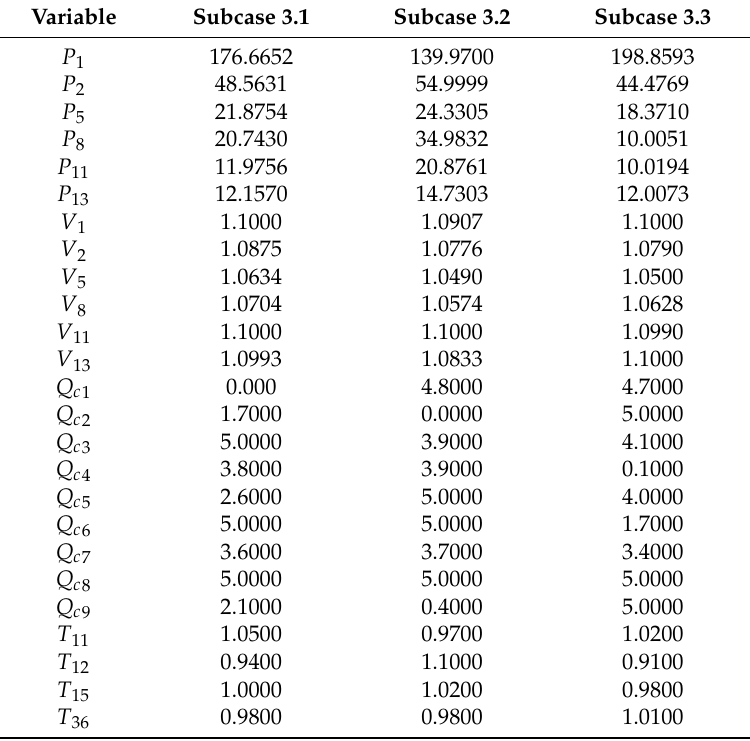
Table A1. Optimal solutions obtained by the proposed method for case 3.